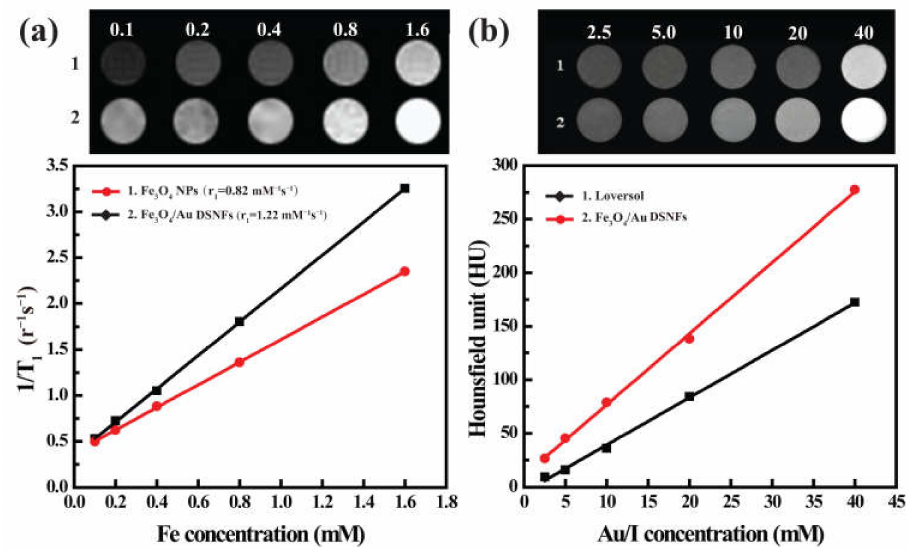
Figure 2. CT and MR imaging properties of the Fe 3 O 4 /Au DSNFs. ( a ) T 1 -weighted MR images and linear fitting of 1/T 1 of the Fe 3 O 4 NPs and Fe 3 O 4 /Au DSNFs at diverse Fe concentrations (1 and 2 refers to USIO NPs and NFs, separately). TE = 12 ms, TR = 377 ms, and ST = 2.0. ( b ) CT images and CT values (HU) of Loversol and Fe 3 O 4 /Au DSNFs with diverse concentrations of the radiodense element of Au or I (1 and 2 refers to Omnipaque and NFs,